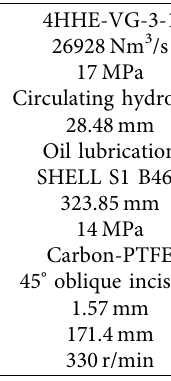
Table 5: Dimensions and parameters of a refnery recovery machine.